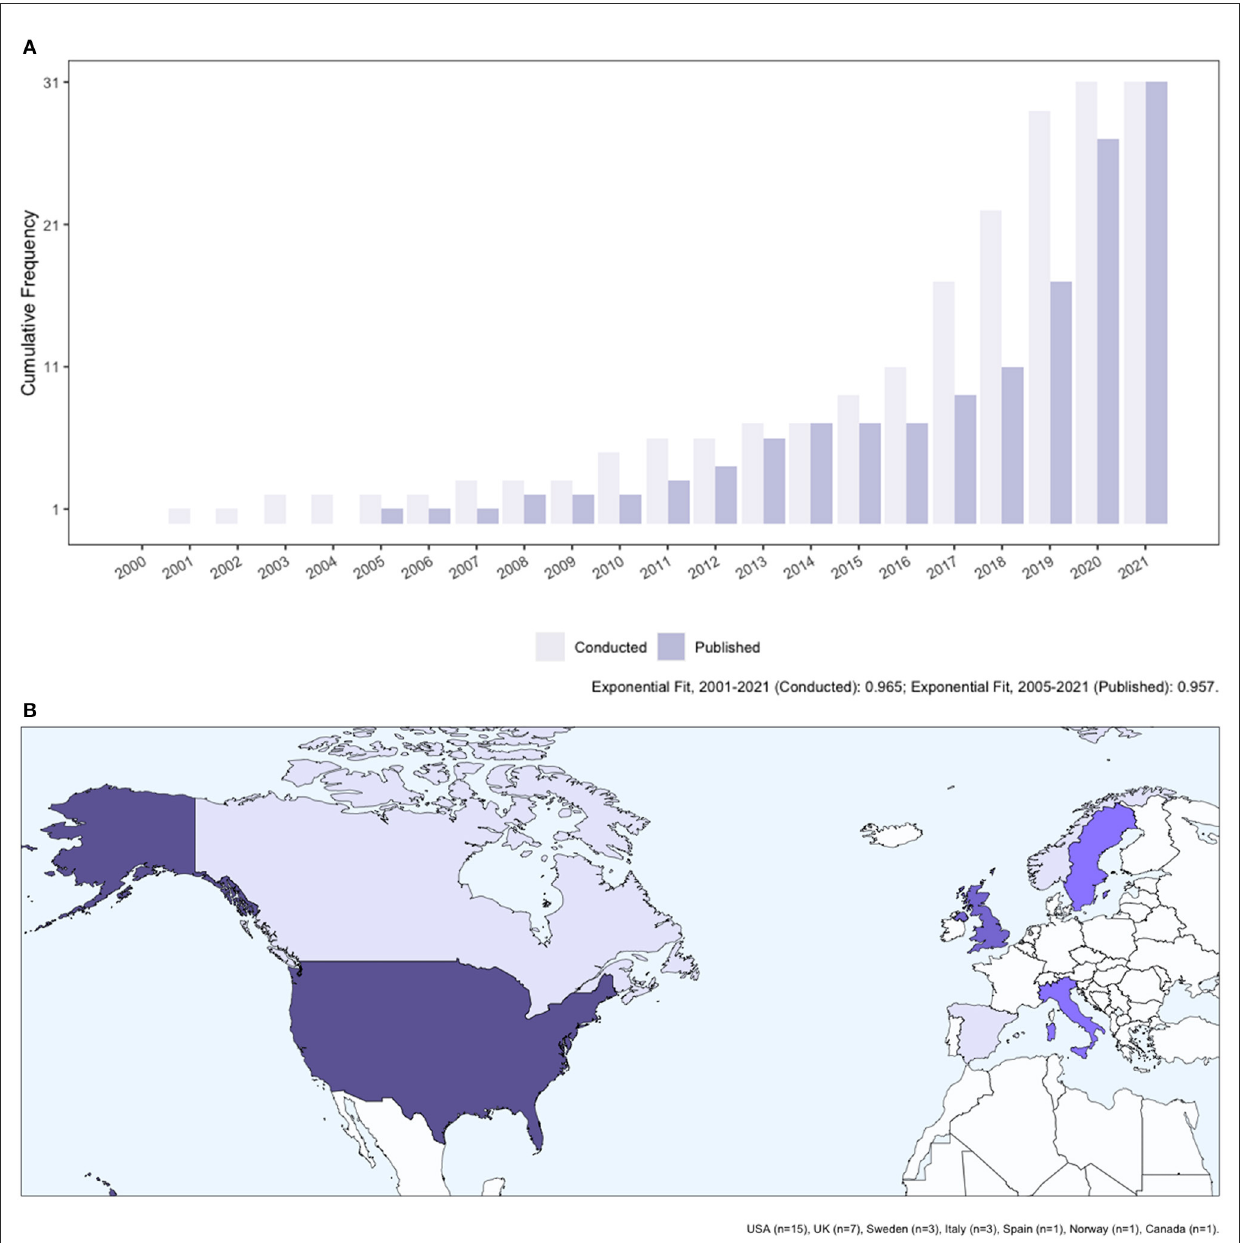
FIGURE3 (A) Grouped bar graph plotting the annual increases in the number of meat reduction interventions implemented within university settings between 2000 and 2021. (B) Choropleth map illustrating the countries where, and frequency with which, included interventions were conducted between 2000 and